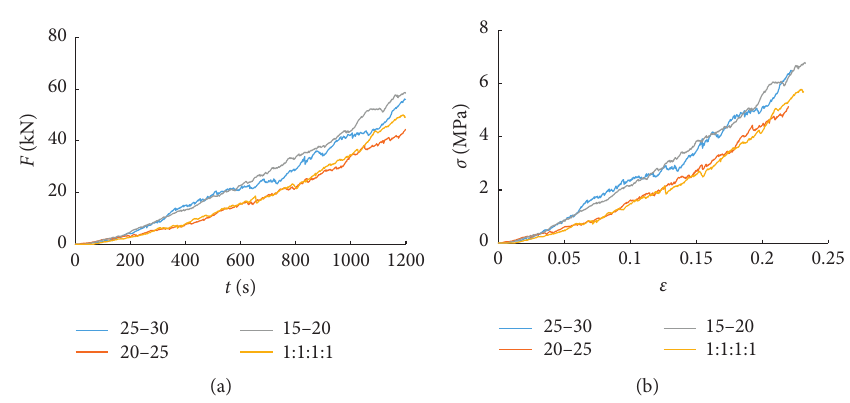
Figure 5: The force-time and stress-strain curves for samples subject to 40mm